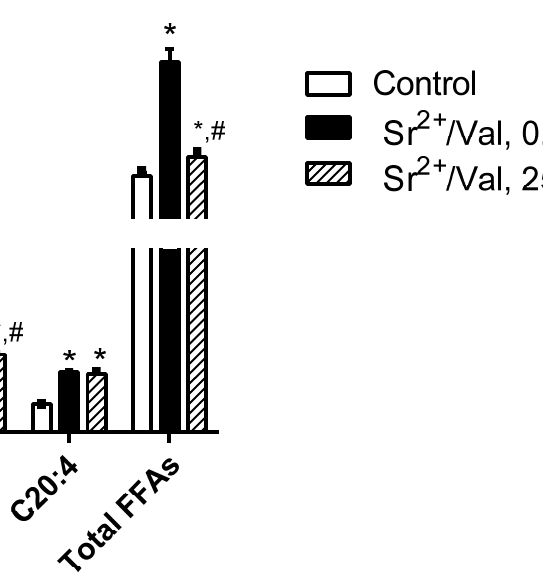
Figure 5. A comparative analysis of the content of the main free fatty acids in rat liver mitochondria before (control) and after the onset of Sr 2+ /valinomycin (Val)-induced ion oscillations in the absence (0.1% DMSO) or presence of 25 µM aristolochic acid (ArA), a phospholipase A 2 (PLA 2 ) inhibitor. The medium and conditions were the same as in Figure 2. The inhibitor of PLA 2 ArA or 0.1% DMSO was added to a mitochondrial suspension 1 min before the addition of Sr 2+ . Data represent the means ± SEM of at least four independent experiments. * p < 0.05 vs. the control group (without additions); # p < 0.05 vs. the experimental group without PLA 2 inhibitor (0.1% DMSO). As has been found earlier, free palmitic and stearic acids in complexes with Sr 2+ (Ca 2+ ) ions can induce the opening of the PA-mPT short-lived pores that are insensitive to CsA and other blockers of the classical mPTP [26,29,30]. To elucidate whether the PA-mPT pore is involved in the ion efflux pathway under long-term Sr 2+ -induced ion oscillations, we investigated the effect of several inhibitors of Ca 2+ (Sr 2+ )-dependent and Ca 2+ (Sr 2+ )-inde- pendent PLA 2 on oscillation propagation. Figure 6 shows the synchronous changes in the ion fluxes of mitochondria pre-incu- bated with the Ca 2+ (Sr 2+ )-dependent PLA 2 inhibitor aristolochic acid (ArA). One can see that the incubation of mitochondria with ArA at a concentration of 25 µM eliminated Sr 2+ - induced cyclic changes in Sr 2+ and K + ion transport, ΔΨ m , mitochondrial matrix volume, as well as the rates of mitochondrial respiration and H 2 O 2 production.